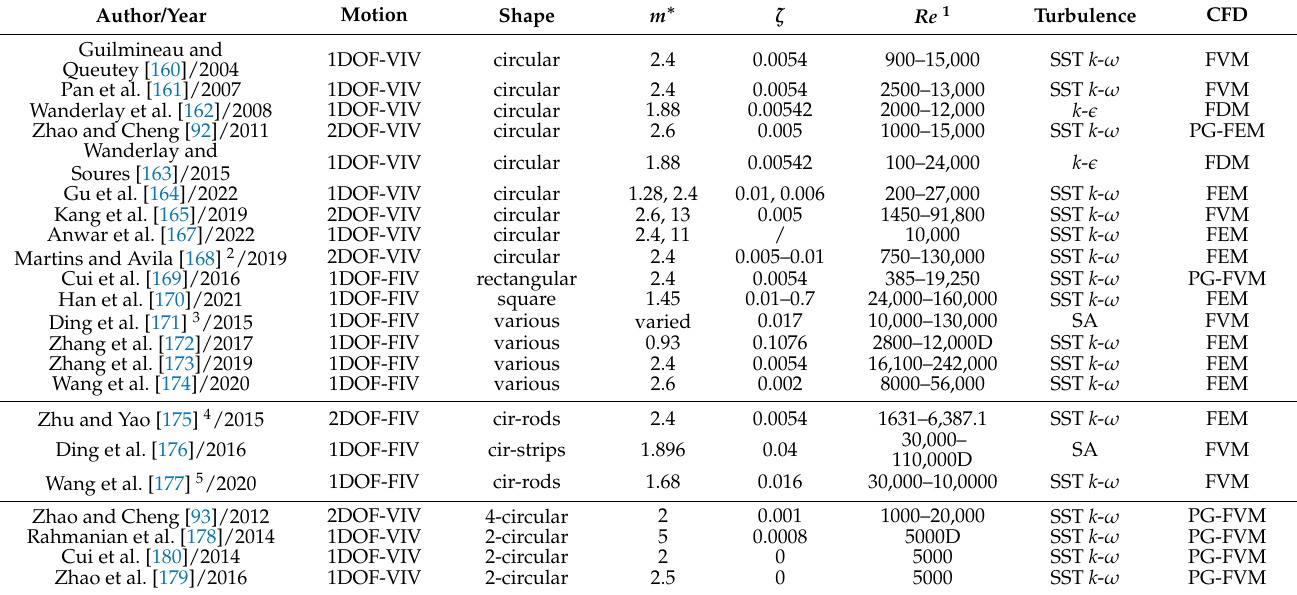
Table 4. Summary of a number of representative RANS modelling studies of flow-induced vibration of bluff